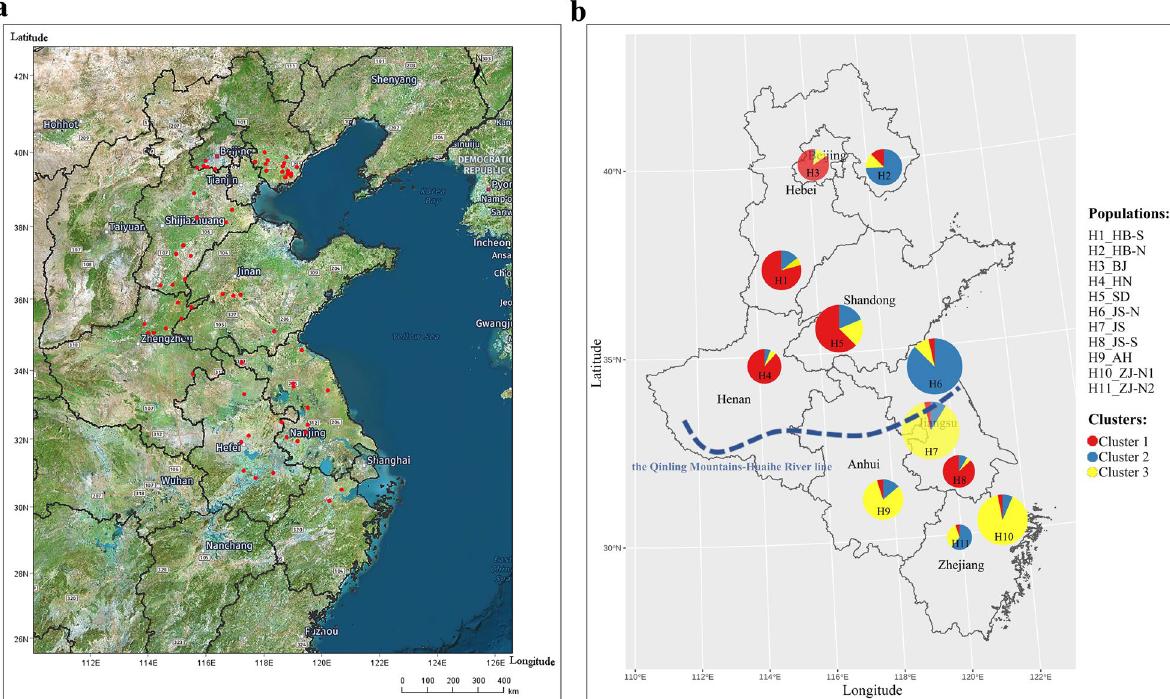
Fig. 2 Populations in eastern China from the Anhui, Beijing, Hebei, Henan, Jiangsu, Shandong, and Zhejiang provinces in 2020. a Geographic topographic map of sampling sites. b Pie chart of 11 populations labeled on the map. Population size is shown in the area of the circle, and population composition is shown with different sections in red (Cluster 1), blue (Cluster 2), and yellow (Cluster 3). The Qinling Mountains-Huaihe River line is shown in the blue line, which represents the geographical dividing line between north and south